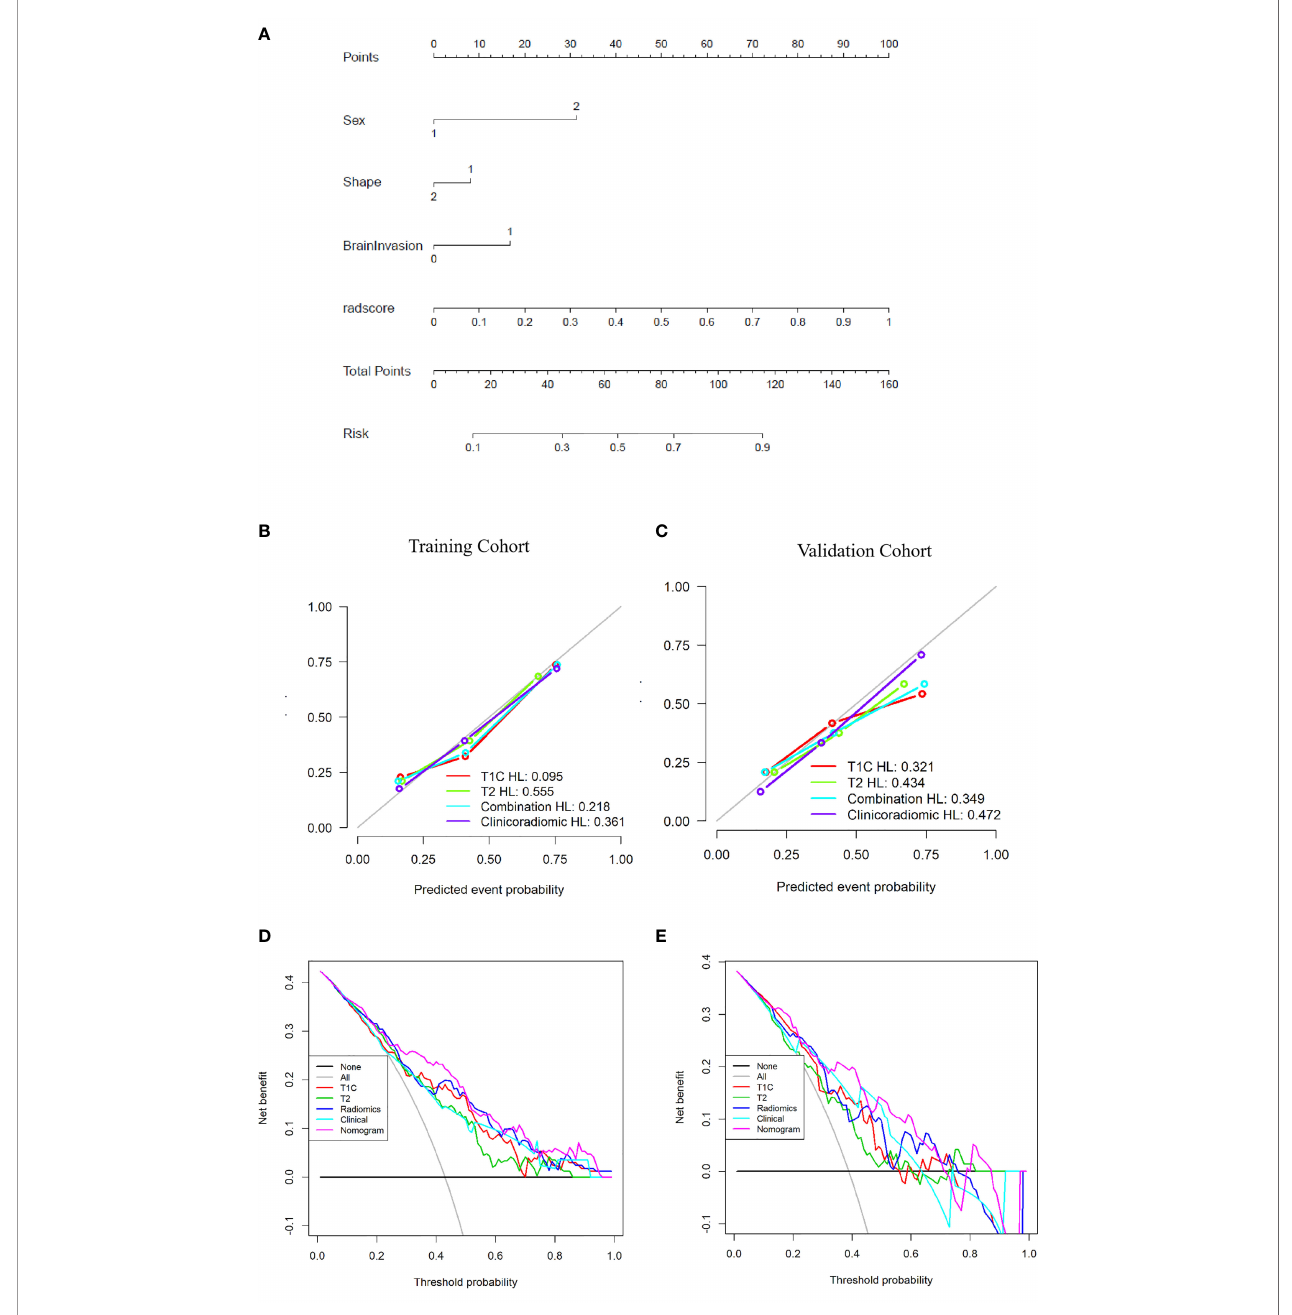
FIGURE 6 | Establishment and performance of the clinicoradiomic model. (A) The clinicoradiomic model is used to develop a nomogram. (B, C) Calibration curves of the clinicoradiomic nomogram for the training and validation cohorts. The x-axis represents the probability of atypical meningioma (AM) and transitional meningioma (TM) as measured by the clinicoradiomic model, and the y-axis represents the actual rate of AM and TM. The solid line represents the discrimination ability of the nomogram, and the diagonal dotted line represents the ideal evaluation by a perfect model. The P -values in the Hosmer-Lemeshow test are 0.361 and 0.472 in the training and validation cohorts, respectively. A closer fi t to the diagonal dotted line represents a better evaluation. (D, E) Decision curve analysis for the clinicoradiomic model. The x-axis shows the threshold probability, and the y-axis measures the net bene fi t. The gray line represents all patients with AM, whereas the black line represents all patients with TM. The pink line represents the clinicoradiomic